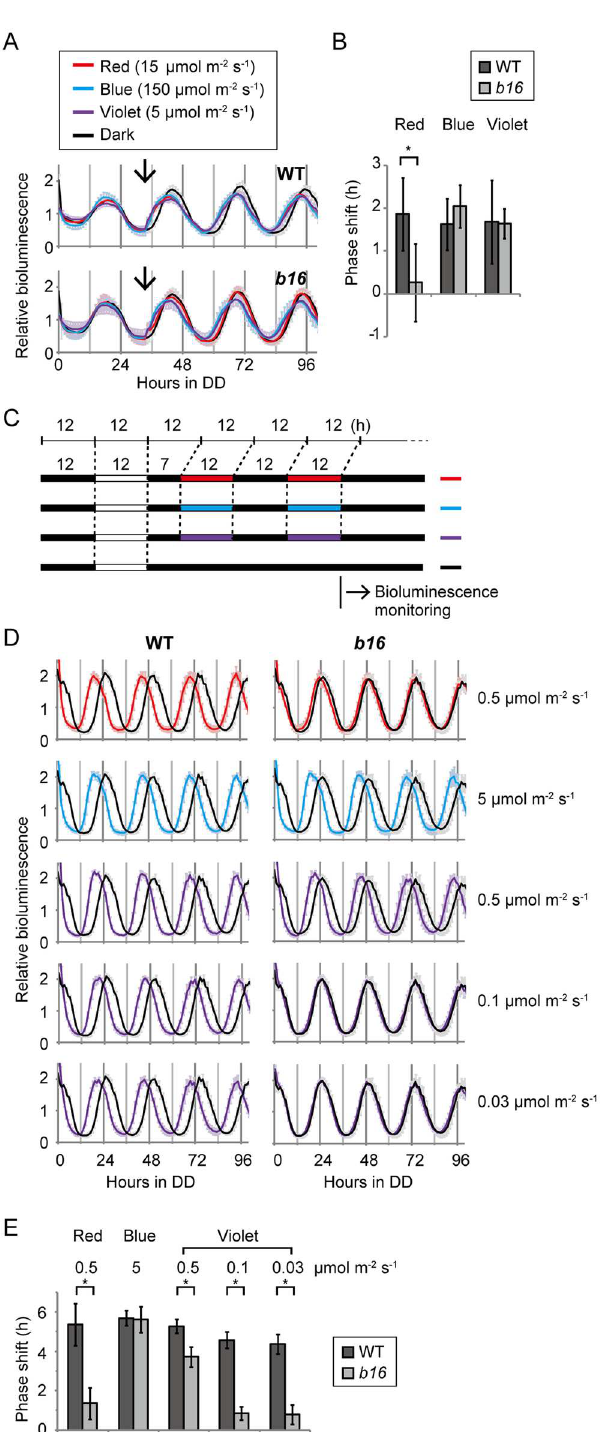
Fig 3. Phase resetting of the circadian clock in the b16 mutant. Bioluminescence rhythms of 5-day-old spot cultures of WT and b16 cells on HS agar media in white 96-wellplates were measured. (A) Bioluminescencetrace of a phaseshifting experiment. Cells were exposedto a 12 h dark/12 h white light to entrain their circadianclock, and then bioluminescence rhythms were monitoredin DD. 5 min light pulses were given at the 34 h time point in DD (arrows). Bioluminescence data are detrended by dividingby the 24 h moving average, and are shown as the mean ± SD of 10 independentcultures. (B) The amount of phase